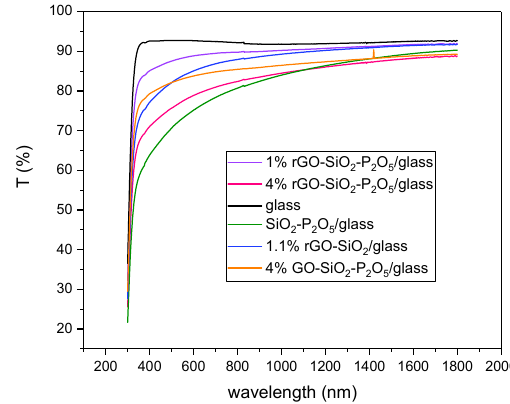
Figure 14. UV-VIS-NIR spectra of the sol-gel films deposited on glass substrate.